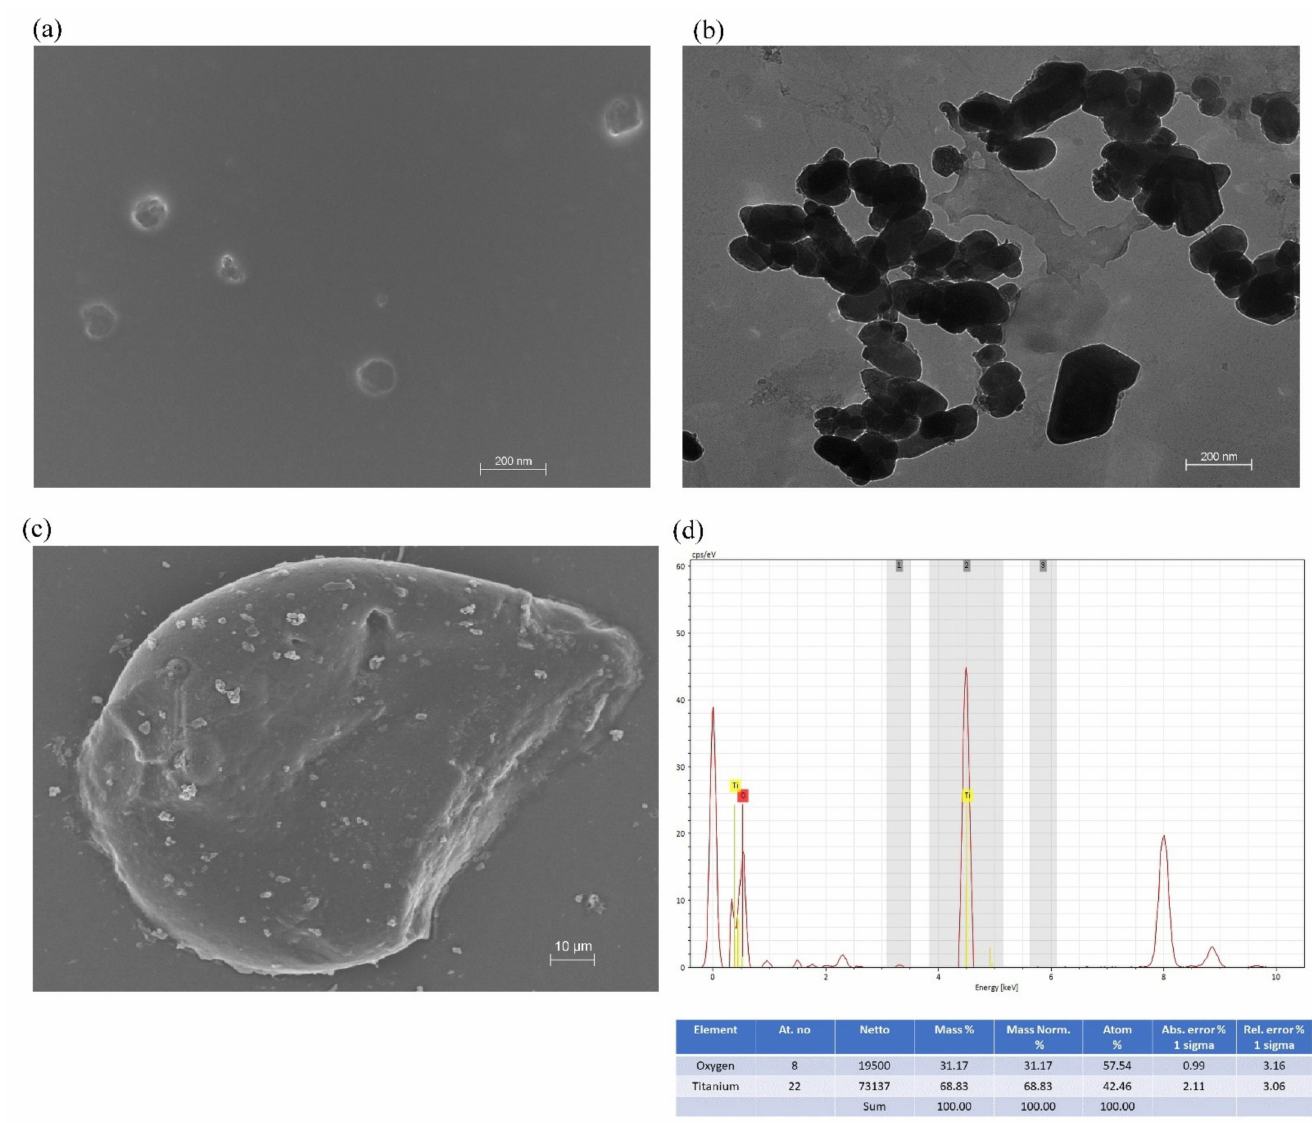
Figure 4. Surface morphology and energy-dispersive X-ray (EDX) analysis of TiO 2 NPs prepared by green synthesis. ( a ) SEM image of TiO 2 NPs. ( b ) TEM image of TiO 2 NPs. ( c ) SEM image of CS gel containing TiO 2 NPs. ( d ) EDX analysis of TiO 2